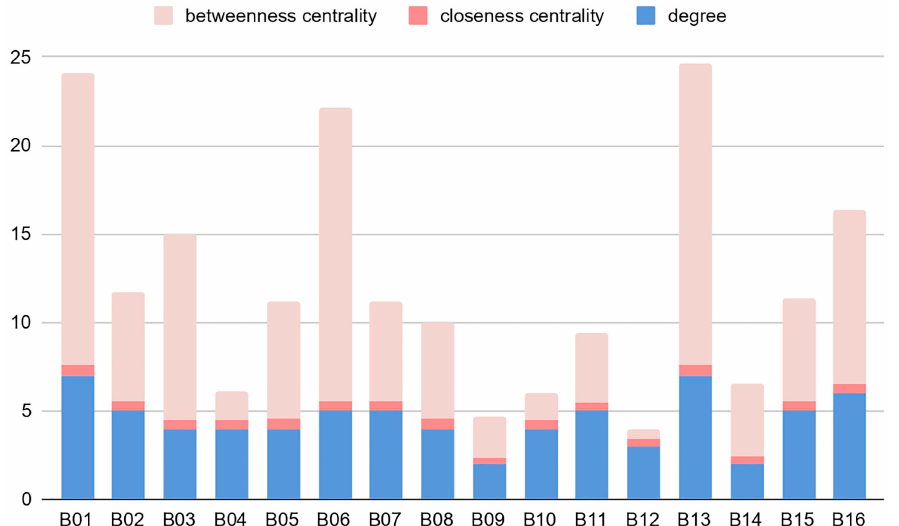
Figure 11. Contrasting Analysis: Degree Centrality, Closeness Centrality, and Betweenness Centrality of Barriers.